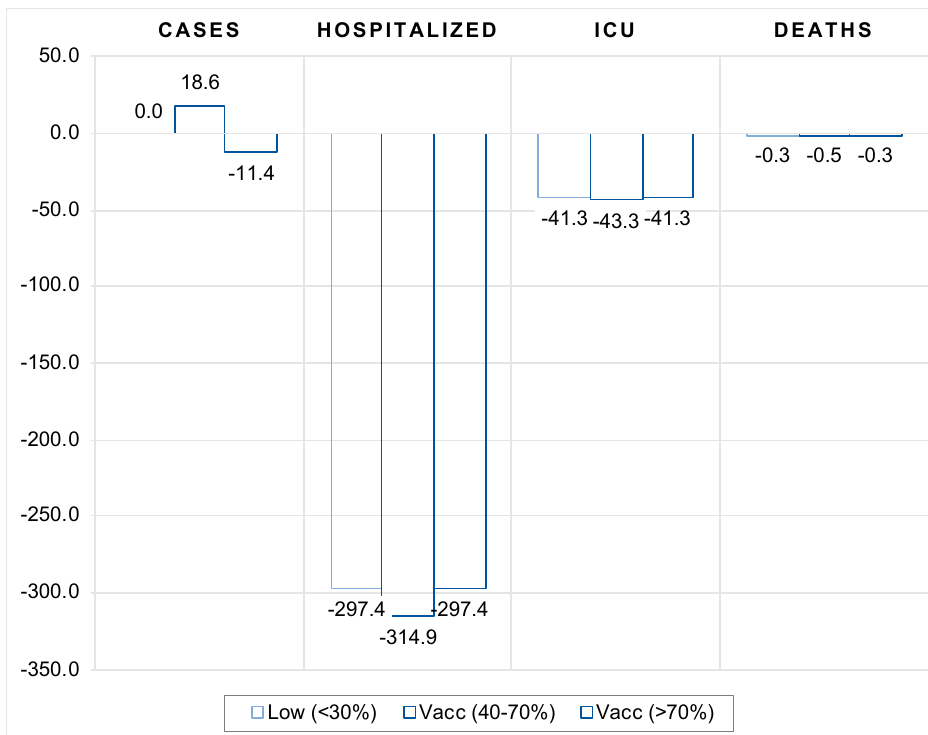
Figure 9. Impact of vaccination rate on number of new cases, hospitalizations, ICU admissions and deaths in 2021 compared to 2020. Notes: Figure contains the estimated coefficients of the per-million number of cases, hospitalized and ICU patients, and new deaths with COVID to vaccination rate obtained by estimating the models (1) and (2). The underlying data were calculated as differences in the corresponding variable between the same 16 weeks of August to November in 2021 and 2020. The vaccination variable is lagged by 4 weeks. Note that for new cases and deaths, data were used for the entire country sample, whereas for hospitalized and intensive care patients, data were only available for most European countries, the United States, Canada, and Israel. See Tables A8 and A9 in the Appendix for the full results and different lags structure.